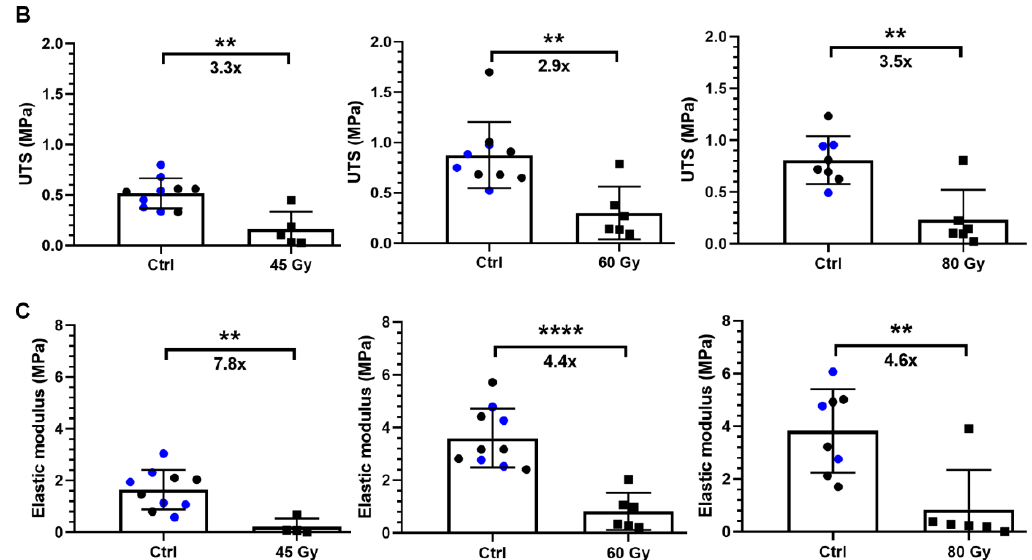
Figure 9. Healing kinetics of incisional wounds created on skin at late stages after irradiation. ( A ) Macroscopic images of the incisional wounds over the course of 17 days after surgery. ( B , C ) Mechanical test results performed 17 days after incisions were performed on normal or previously irradiated healed skin. ( B ) Ultimate tensile strength values. ( C ) Elastic modulus values. Data originating from the non-irradiated control mice are shown in dark blue in the graphs. Statistics: mean ± SD. n = 5–6 wounds for irradiated skin and n = 8–10 wounds for control skin. Unpaired t -tests ** p < 0.01, **** p < 0.0001. Table 3. Ultimate tensile strength values for intact non-wounded skin compared with normal and irradiated skin incisions.